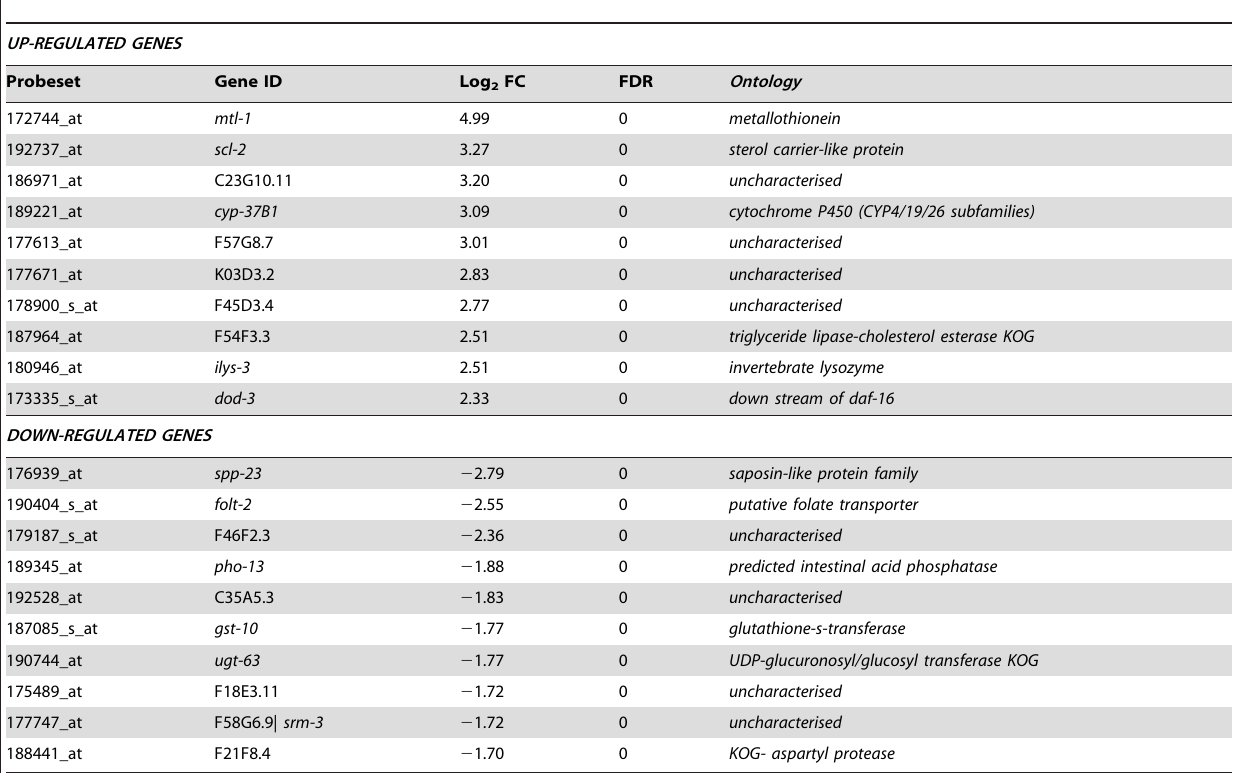
Table 2. Top 10 up-regulated and down-regulated genes based on fold change following 4 hr exposure of DA1316 to 1 m g/ml (1.1 m M) IVM.